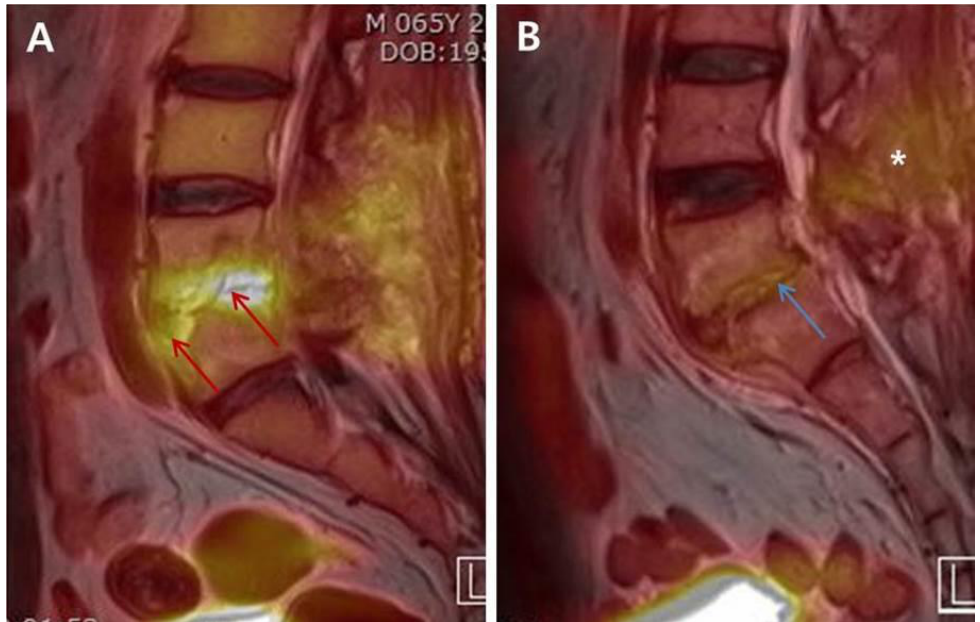
Figure 1. The differences in the intensity and distribution of FDG uptake between “ Non-cured ” and “ Cured ” simultaneous FDG-PET/MRIs. A 65-year-old male patient diagnosed with postoperative PVO was treated with 1st cephalosporin under the identification of MSSA. The clinical assessment on 21 st days of parenteral antibiotic therapy showed sustained back pain, intermittent mild fever, and ESR/CRP 120/2.84. Simultaneous FDG-PET/MRI of “ Non-cured ” revealed an increased FDG uptake (red arrow; SUV max 6.06; grade III of distribution-based interpretation criteria) on the anterior portion of L5 body and disc of L4 – L5 ( A ). A 58-year-old male patient diagnosed with postoperative PVO presenting culture-negative was treated with vancomycin. The patient showed improved back pain, no fever, and ESR/CRP 61/0.343 in the clinical assessment on 45th days. FDG uptake decreased overall and limited on disc and endplates (blue arrow; SUV max 3.12; Grade II) on simultaneous FDG-PET/MRI of “ Cured ” . There is also decrease of FDG uptake on posterior structures including back muscle layer (white asterisk) ( B ). Abbreviations: FDG = 18 F-fluorodeoxyglucose; PVO = pyogenic vertebral osteomyelitis; MSSA = methicillin-sensitive Staphylococcus aureus ; ESR = erythrocyte sedimentation rate (mm/h, normal range: < 25 mm/h); CRP = C-reactive protein (mg/dL, normal range: < 0.5 mg/dL); FDG-PET/MRI = 18 F-fluorodeoxyglucose positron emission tomography/magnetic resonance imaging; SUV max = maximum standardized uptake value of FDG.